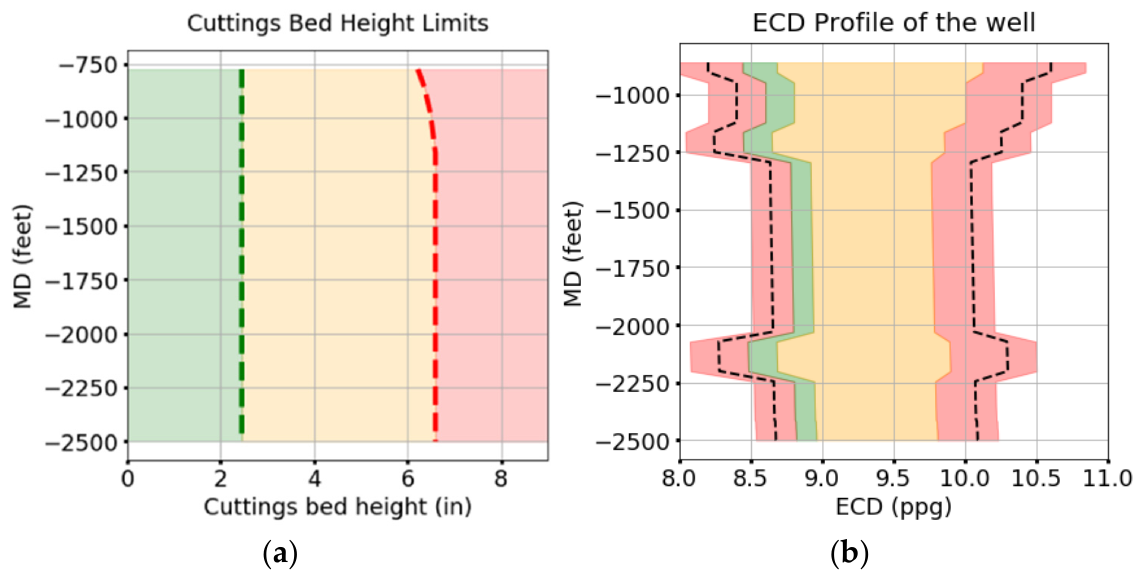
Figure 13. ( a ) Limits of the cuttings bed height profile. ( b )The drilling margin for the well considering a ten percent uncertainty in the SL and FG limits (negative sign indicates downward depth into the sub-surface).